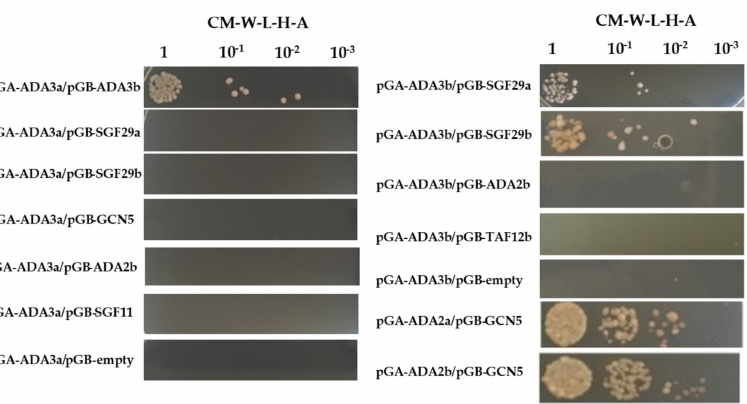
Figure 8. Yeast two hybrid assays of protein-protein interactions between ADA3a and ADA3b and other members of the Arabidopsis thaliana SAGA-like